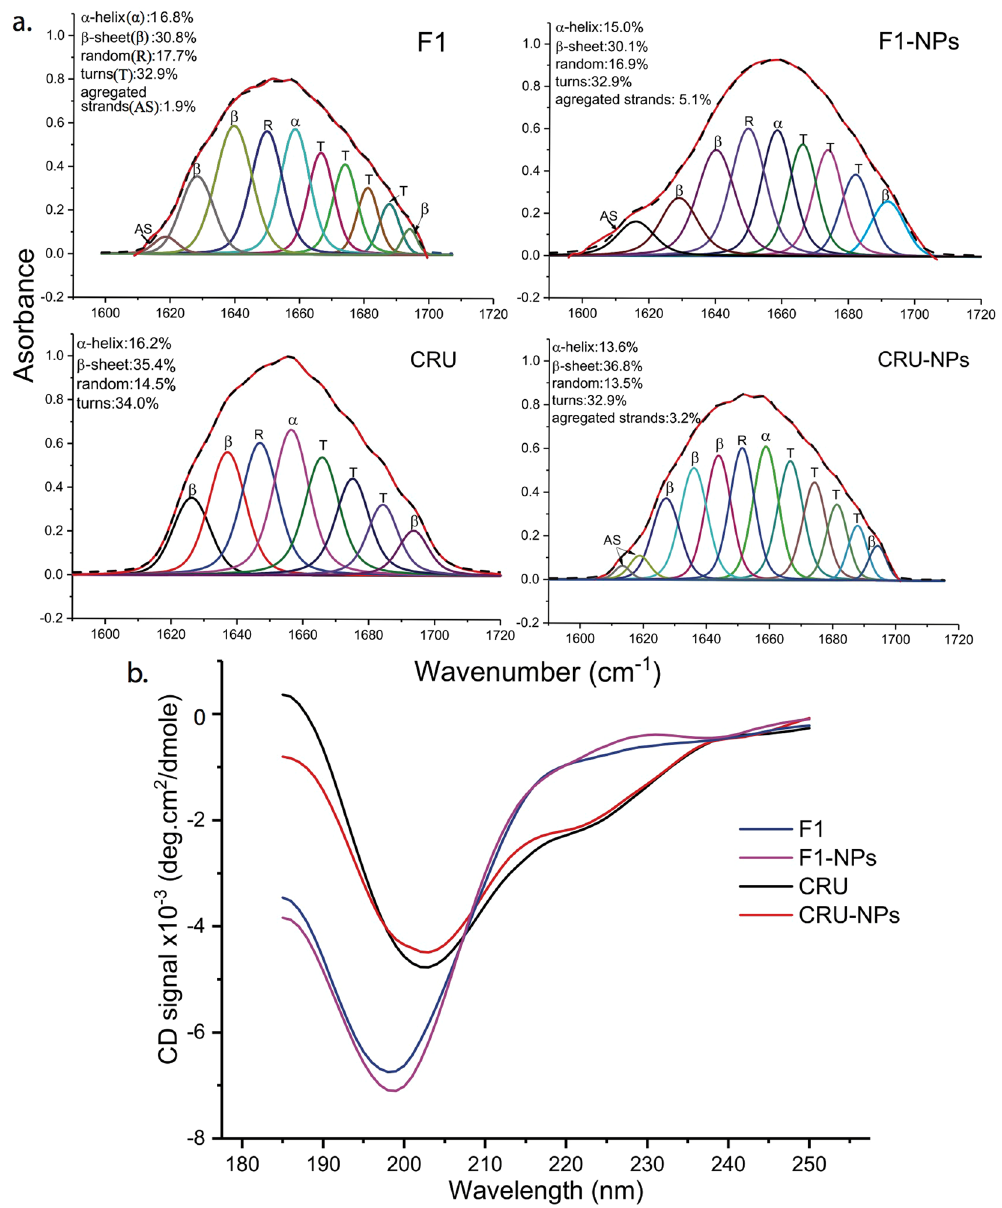
Figure 2. Fourier self-deconvoluted absorbance spectra ( a ) and circular dichroism spectra ( b ) of CRU (cruciferin peptides), F1 (cruciferin peptide fraction < 10 kDa), CRU-NPs (nanoparticles formed from cruciferin peptides), and F1-NPs (nanoparticles formed from cruciferin peptide fraction < 10 kDa) at amide I band between 1,600–1,700 cm − 1 . The dotted lines resulted from self-deconvolution of experimental data (outside solid line) and inside solid lines are fitted